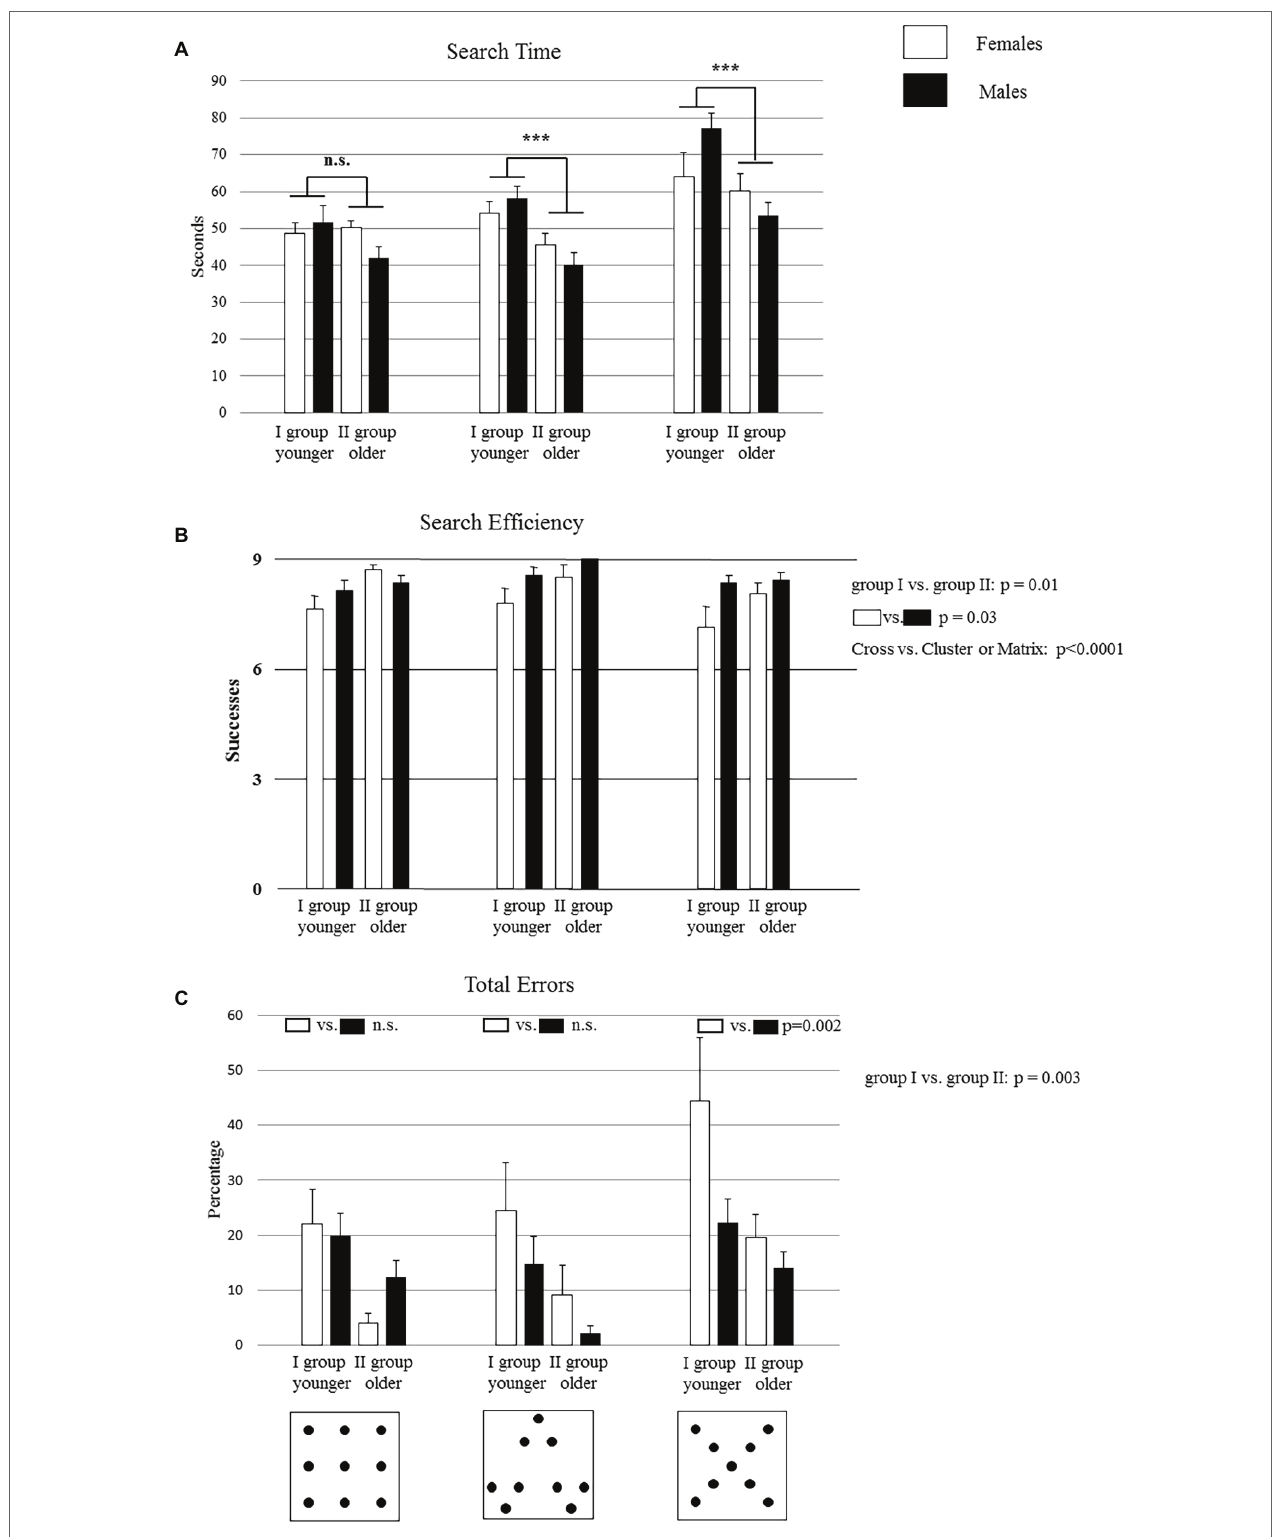
FIGURE 1 | Performances of group I and group II on the search task in Matrix, Cluster, and Cross configurations. Bucket arrangement in the three configurations is depicted in the figures below the graphs (A,B,C) . Data are presented as mean ± SEM. Asterisks and the p values inside the graphs (A,C) indicate the significance level of post hoc comparisons on the second-order interactions: *** p < 0.0005. The p values of the main factors are reported on the right side of each